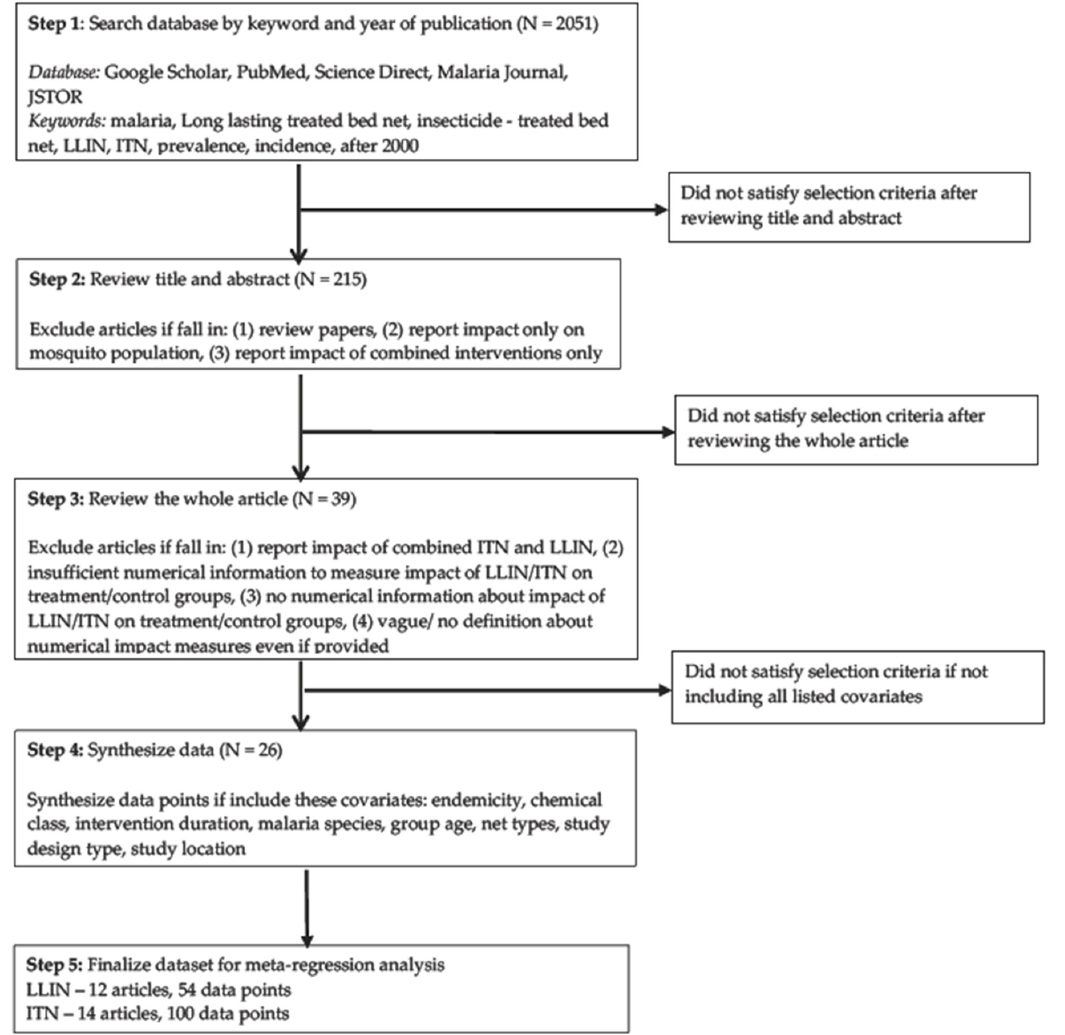
Figure 1. Methodology of searching for and selecting studies to include in meta-regression analysis.